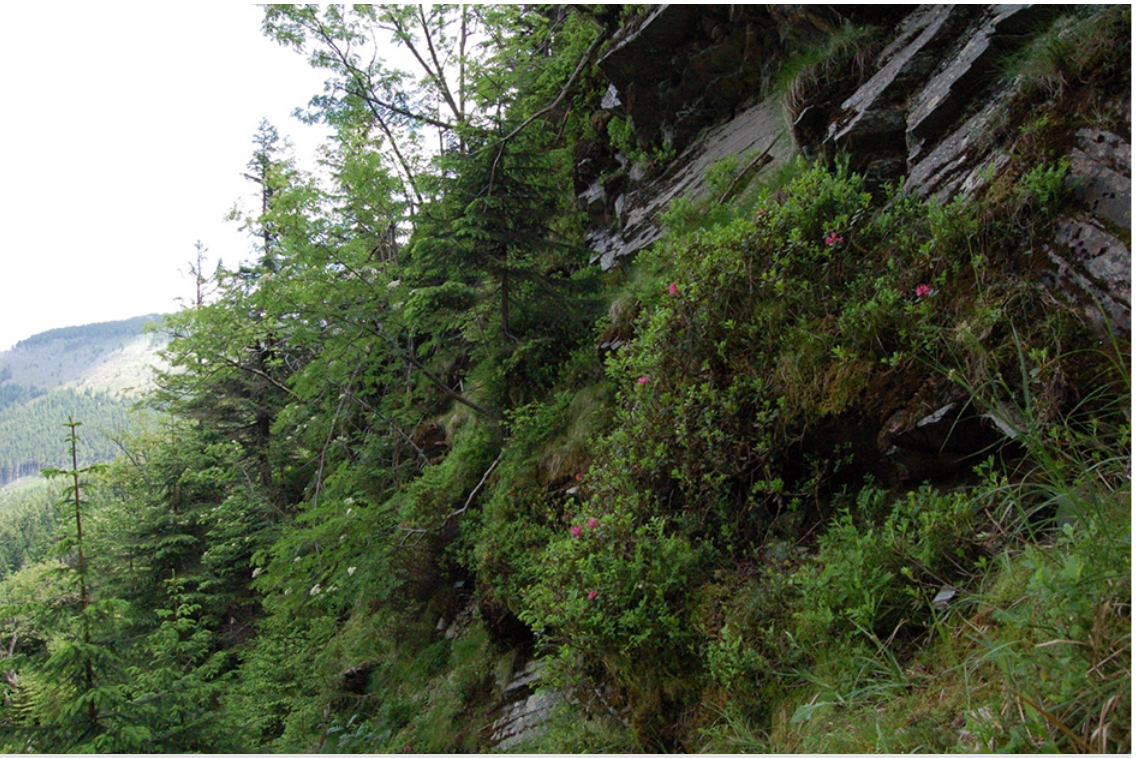
Fig. 2 General view of the rock outcrop and the population of Rhododendron ferrugineum in the Sowia Dolina, Karkonosze Mts (Poland).